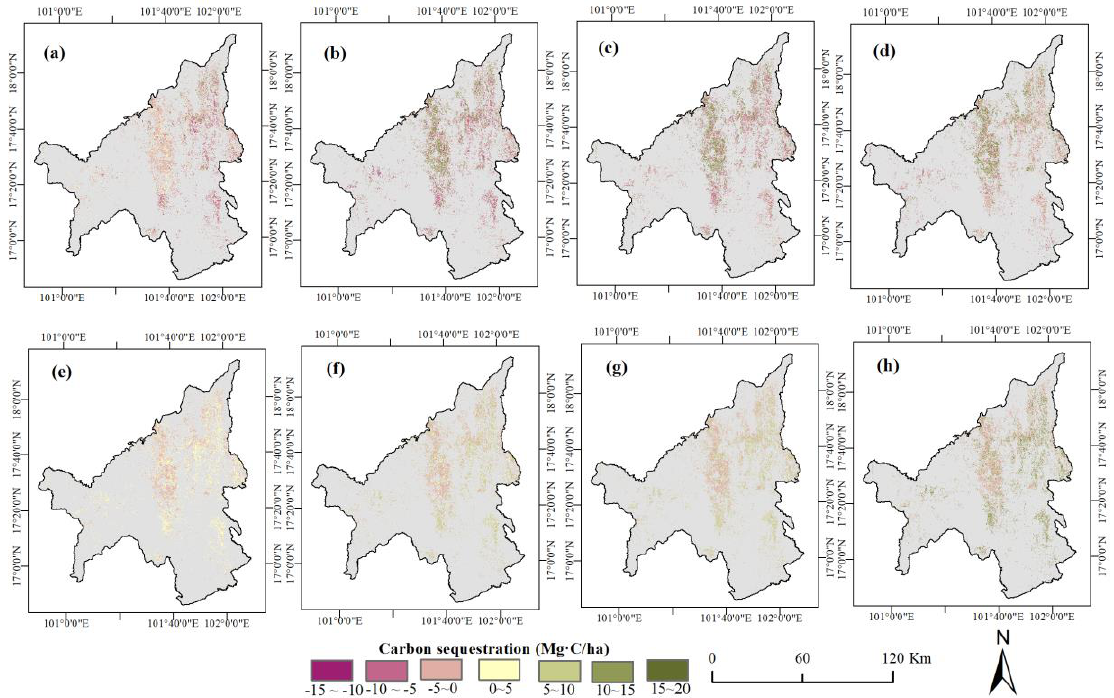
Figure 9. Spatial and temporal patterns of cumulative carbon sequestration in different periods (corresponding to 1999–2004, 2005–2009, 2010–2014, and 2015–2018; ( a – d ) and ( e – h ) represent the cumulative carbon sequestration under actual rubber planting and hypothetical no-rubber-planting scenarios, respectively).